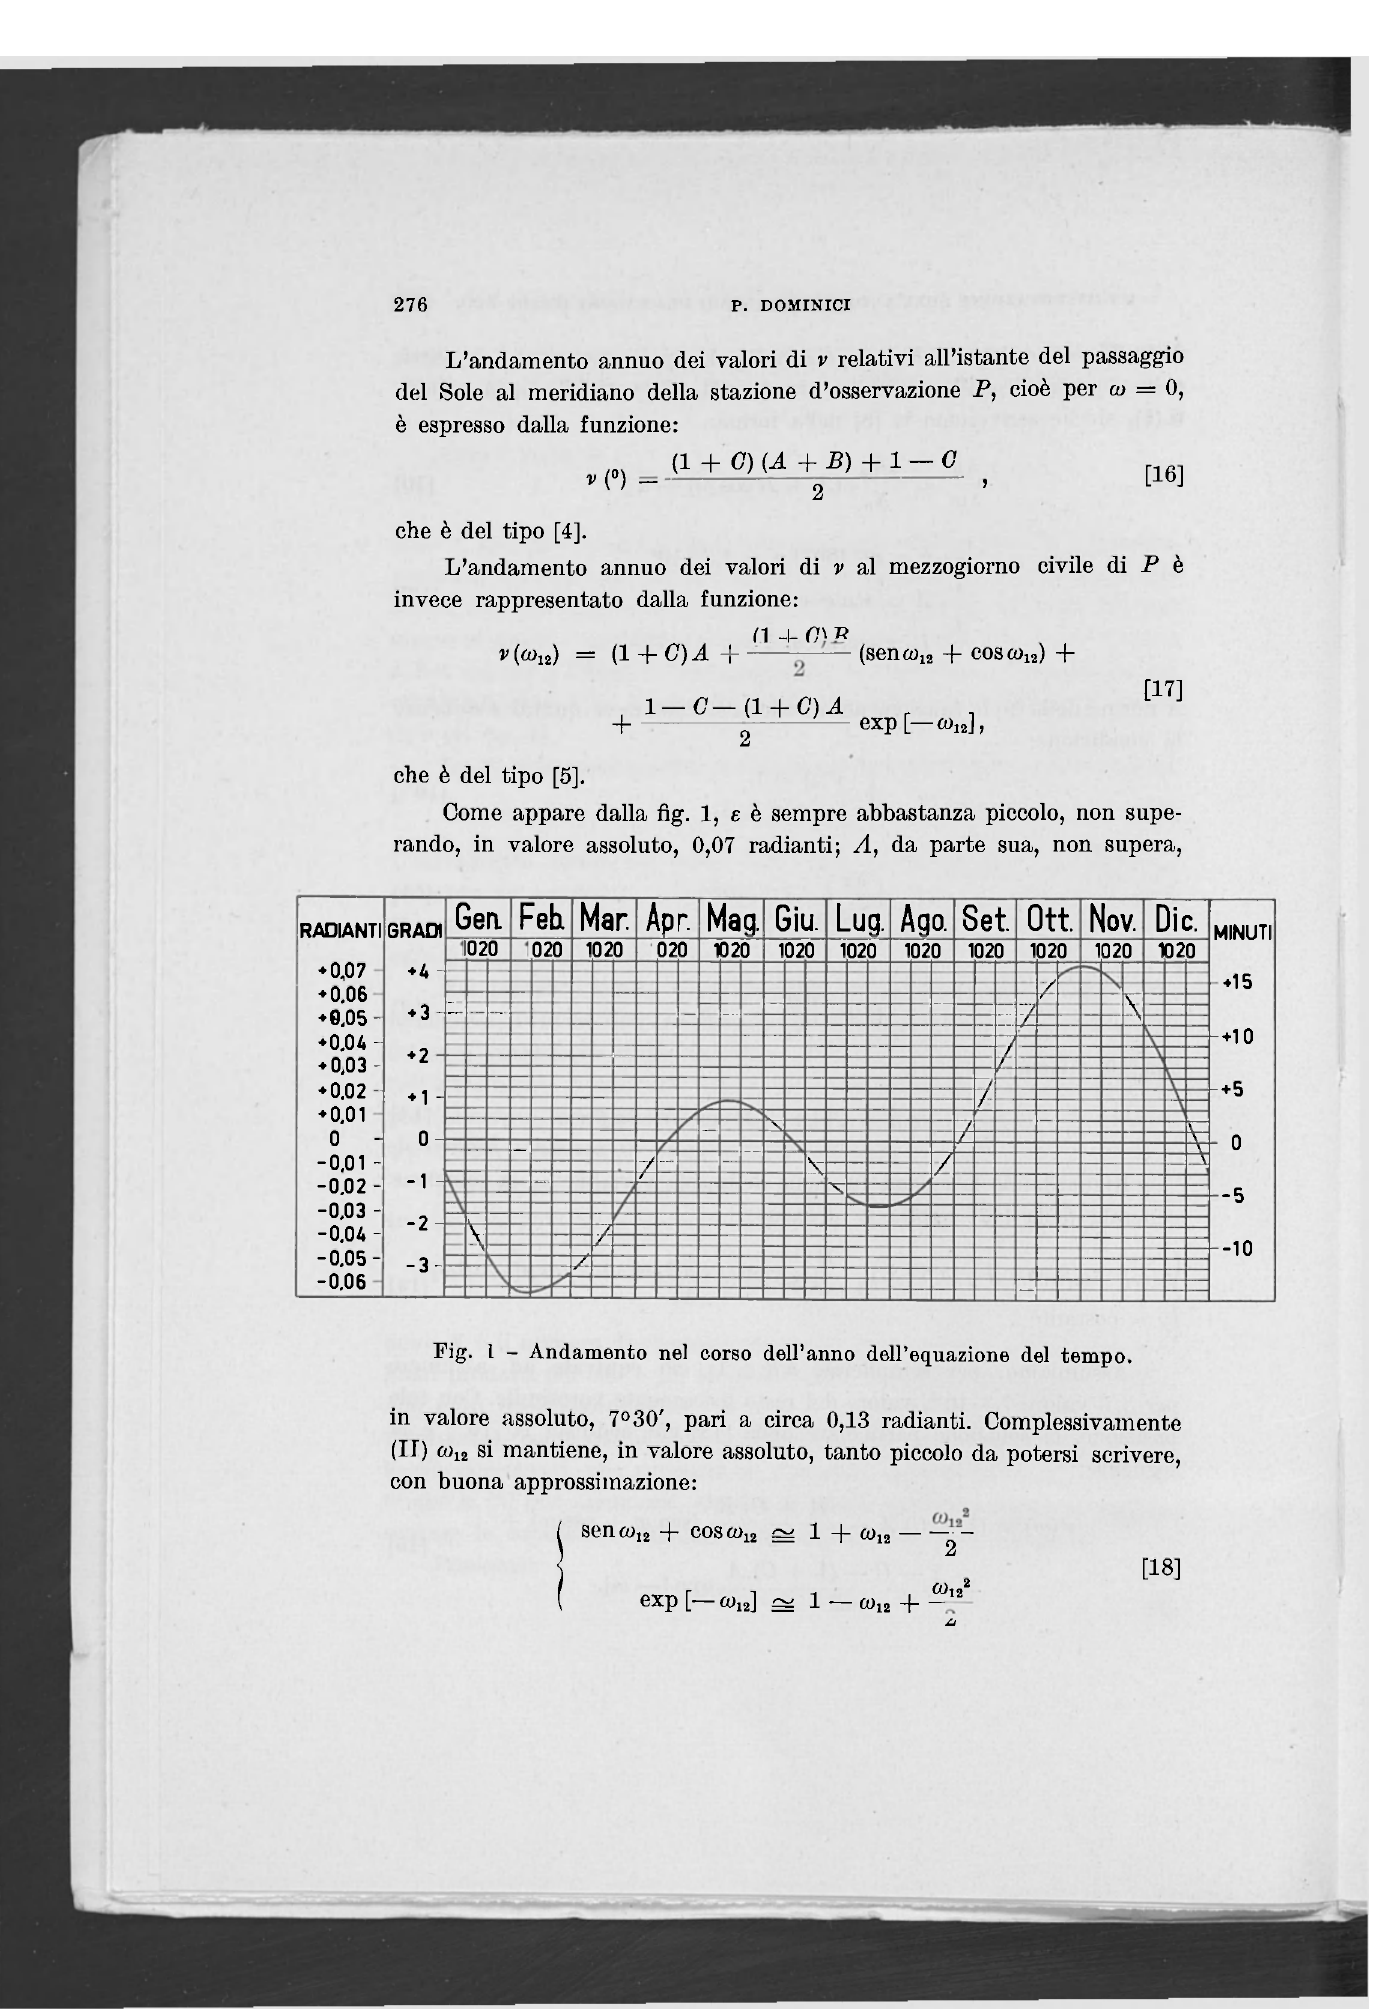
Fig. 1 - Andamento nel corso dell'anno dell'equazione del